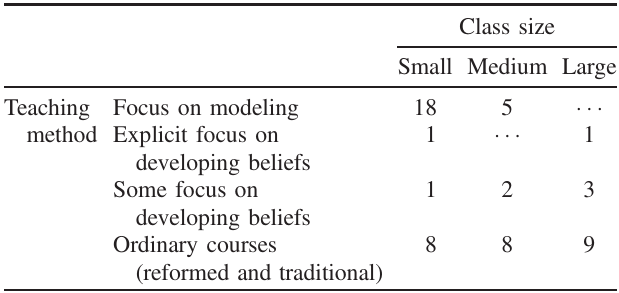
TABLE V. Number of courses for each combination of class size and teaching method, “ (cid:2) (cid:2) (cid:2) ” indicates no courses have a given combination.